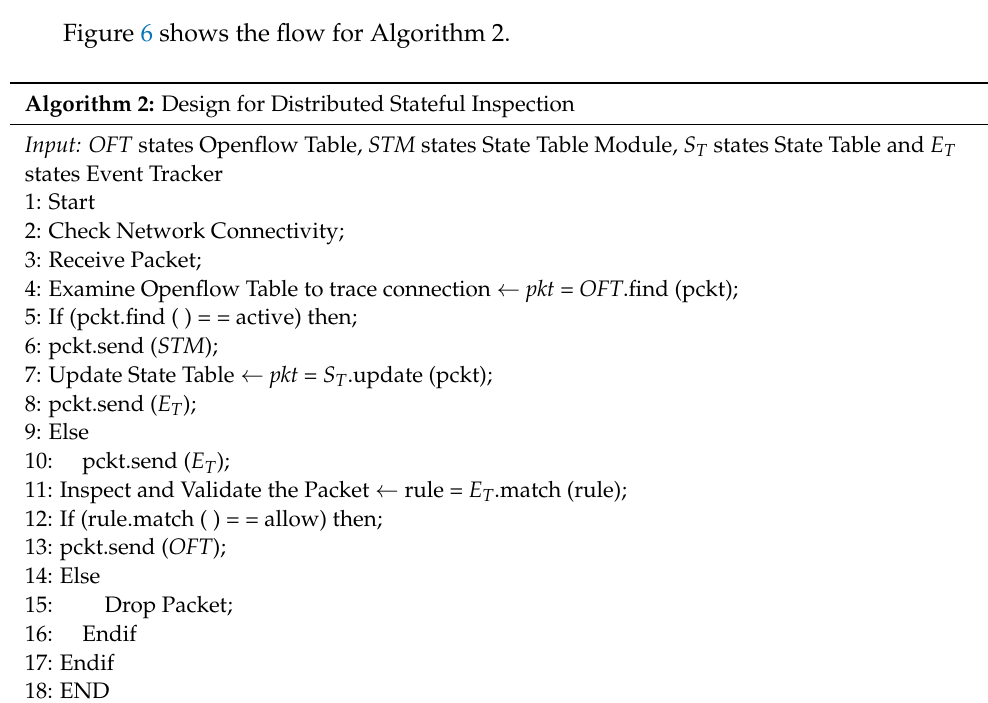
Algorithm 2: Design for Distributed Stateful Inspection and E T states Event Tracker